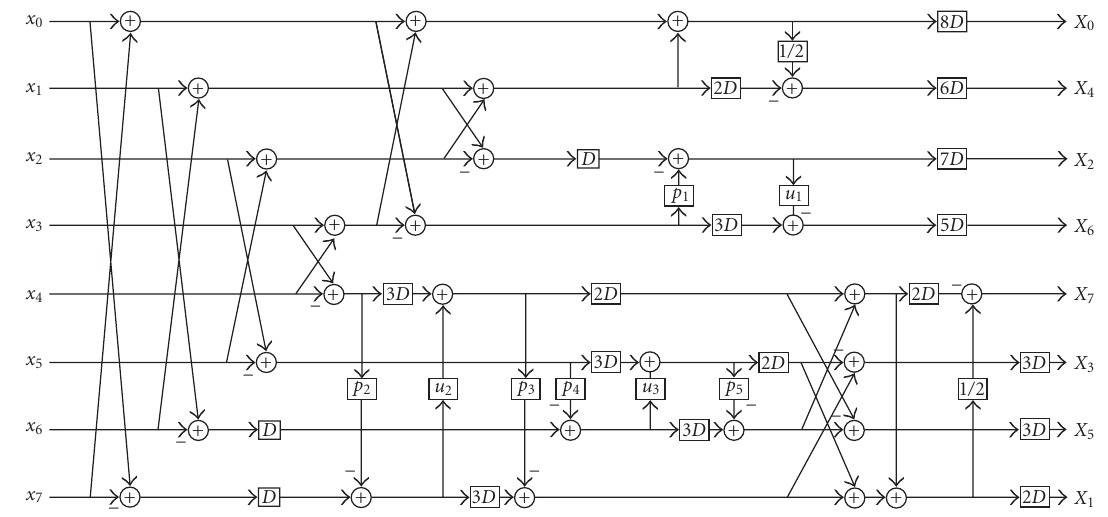
Figure 3: Signal flow graph of the pipelined Loe ffl er’s factorization with the lifting structure.